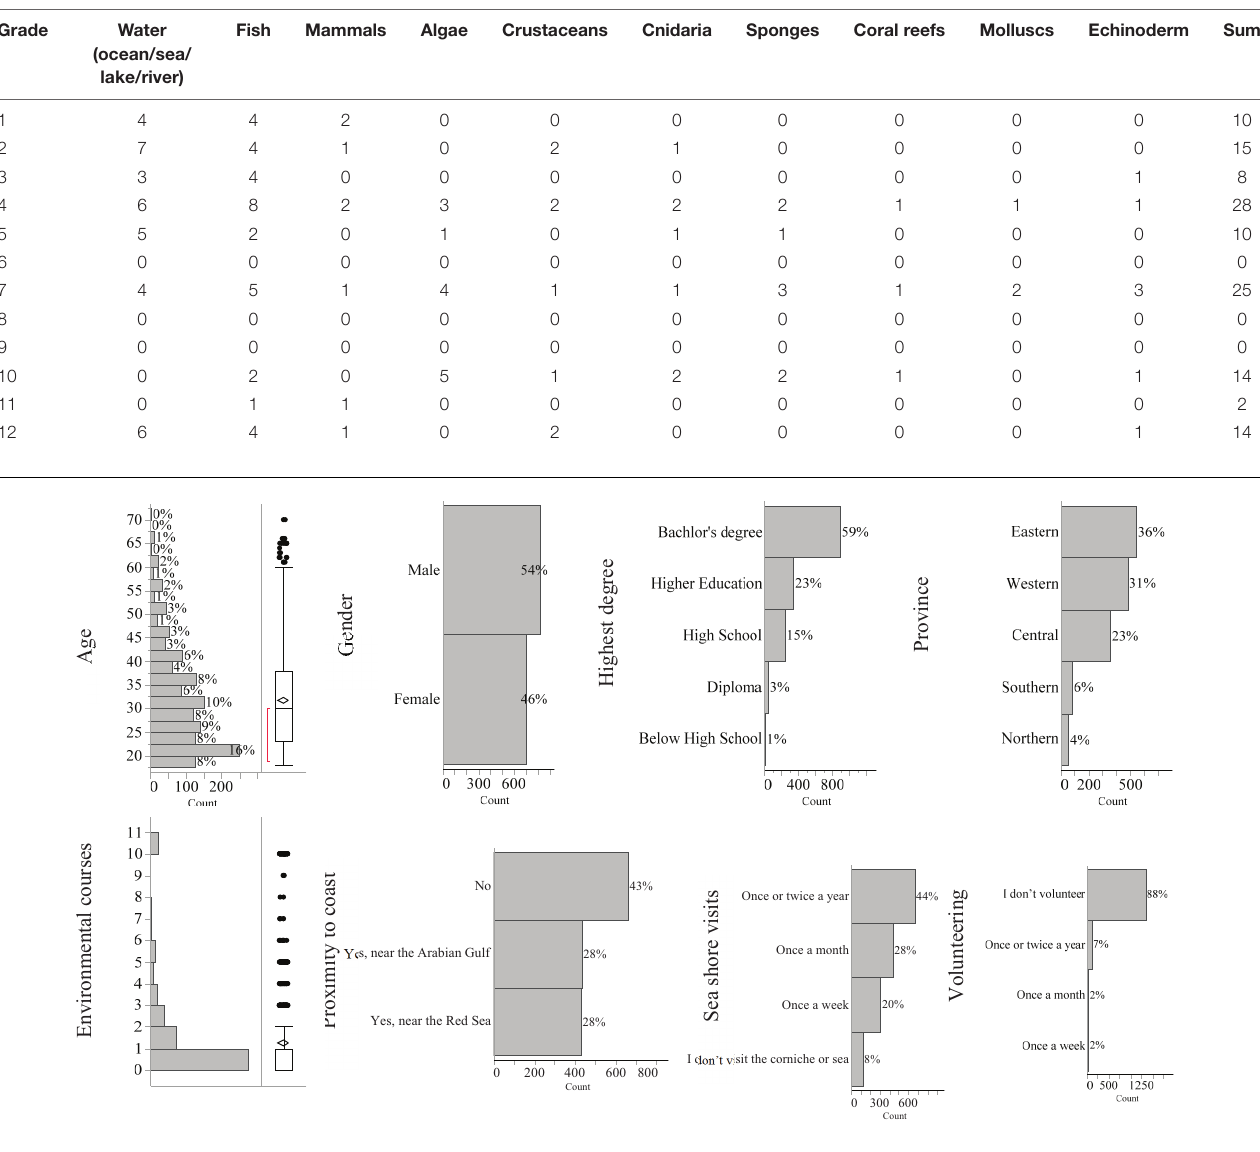
TABLE 1 | Number of subjects related to marine environment in Saudi students’ books from grade 1 to grade 12. Grade Water Fish Mammals Algae (ocean/sea/ lake/river)